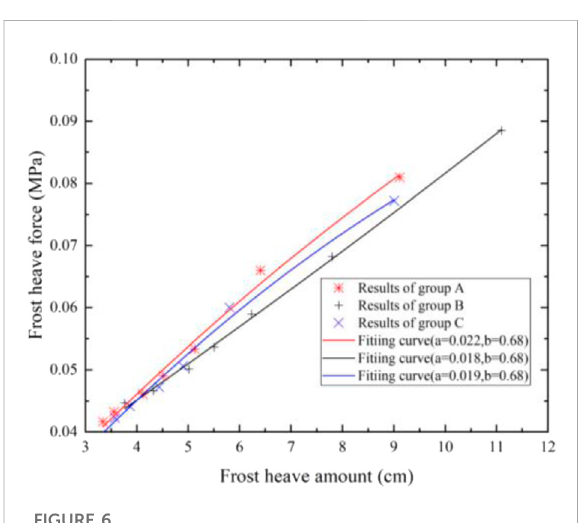
FIGURE 6 Relationship between frost heave force and frost heave amount under different